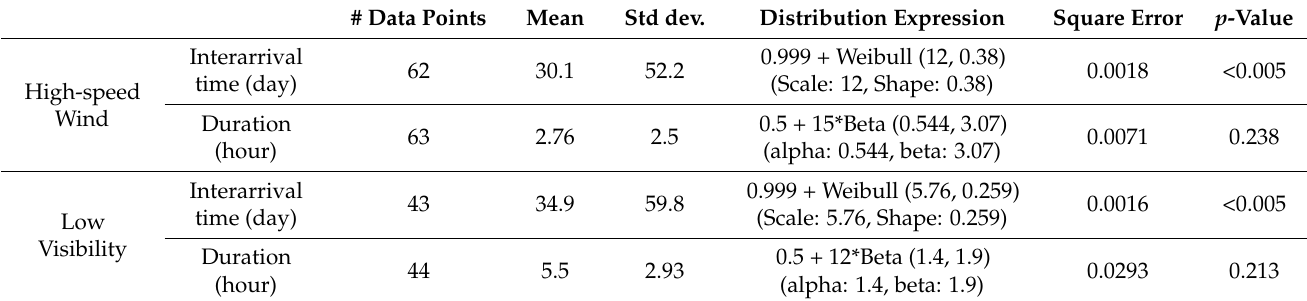
Table 5. High-speed wind and low visibility data and fitted